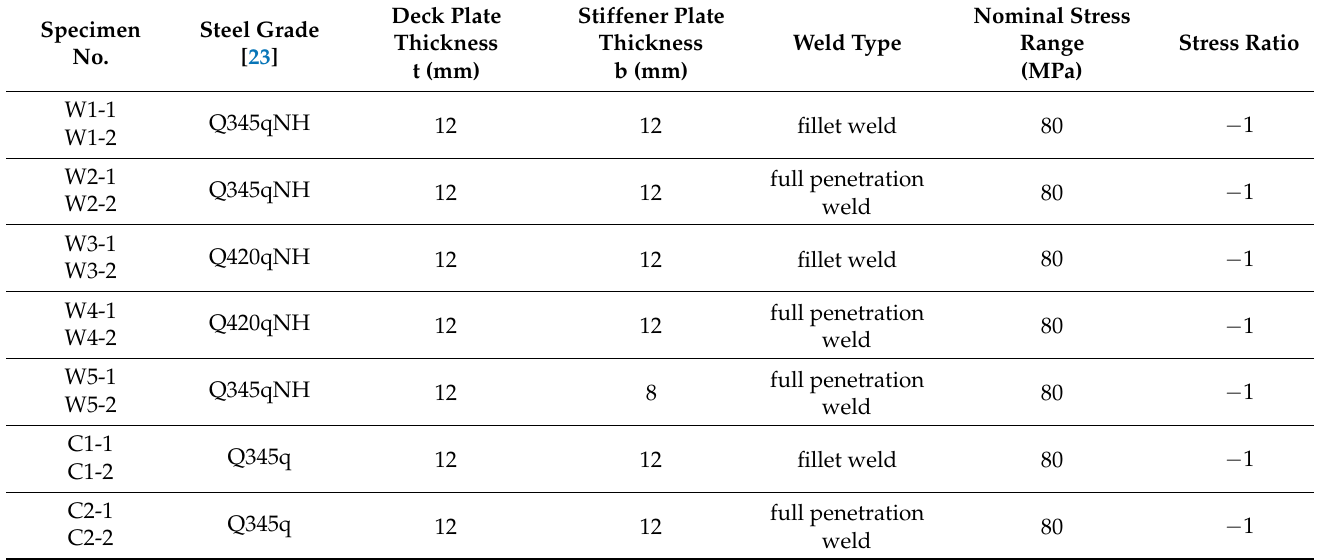
Table 1. Parameters of test specimens.